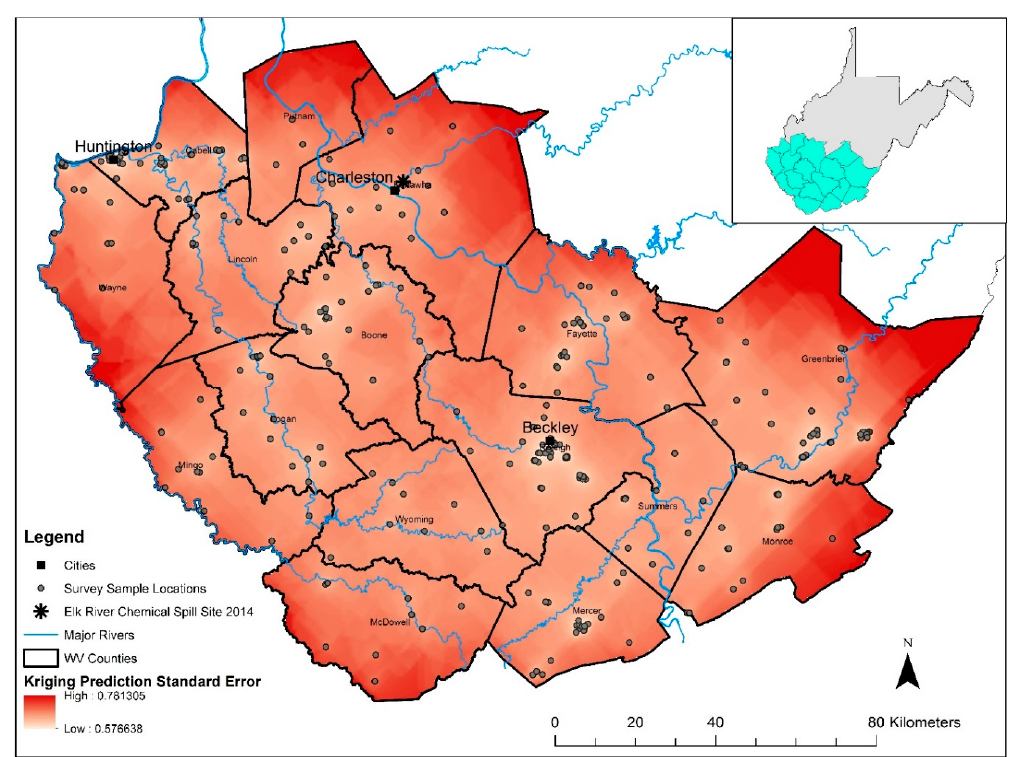
Figure 3. Kriging interpolated prediction surface standard error for overall water quality perception scores across study area in Southern West Virginia. Values range from 0.57 (lighter colors) to 0.78 (dark red) across the study area.